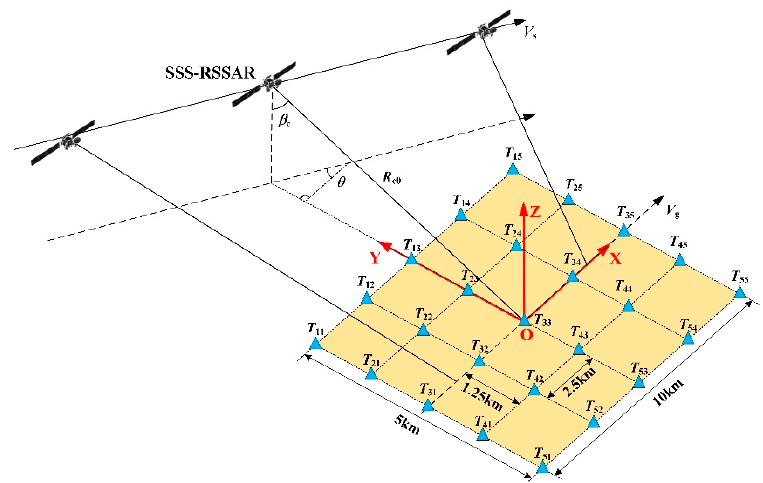
Figure 8. Target distribution for the SSS-RSSAR simulation.